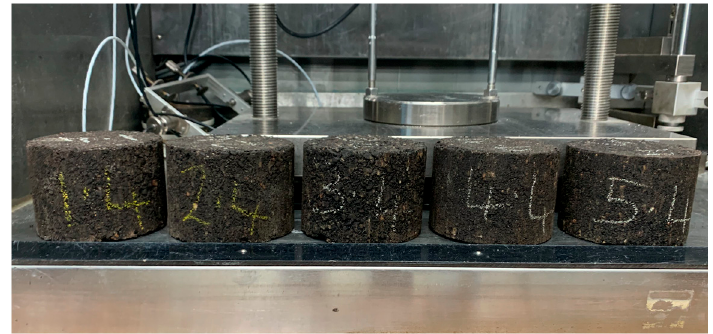
Figure 2. Marshall Compactor samples.